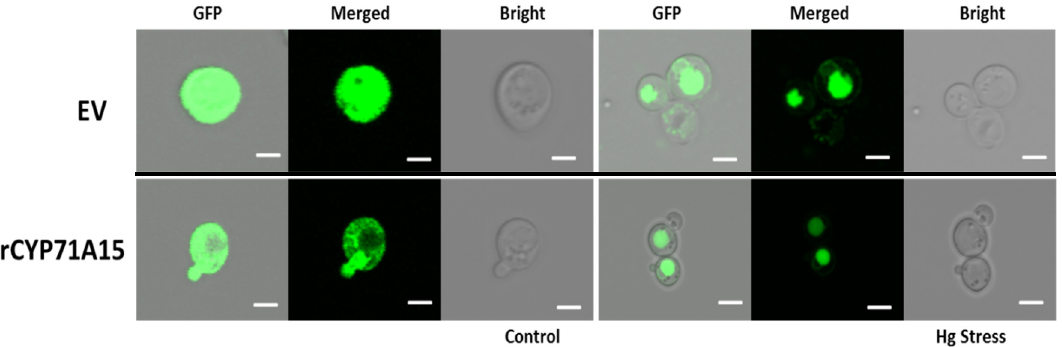
Figure 8. The subcellular localization of BrCYP71A15 and empty vector tagged with GFP and transiently expressed in yeast cells treated with 100 mM Hg. The images were obtained from GFP, merged and bright channels. Scale bar: 10 μm.